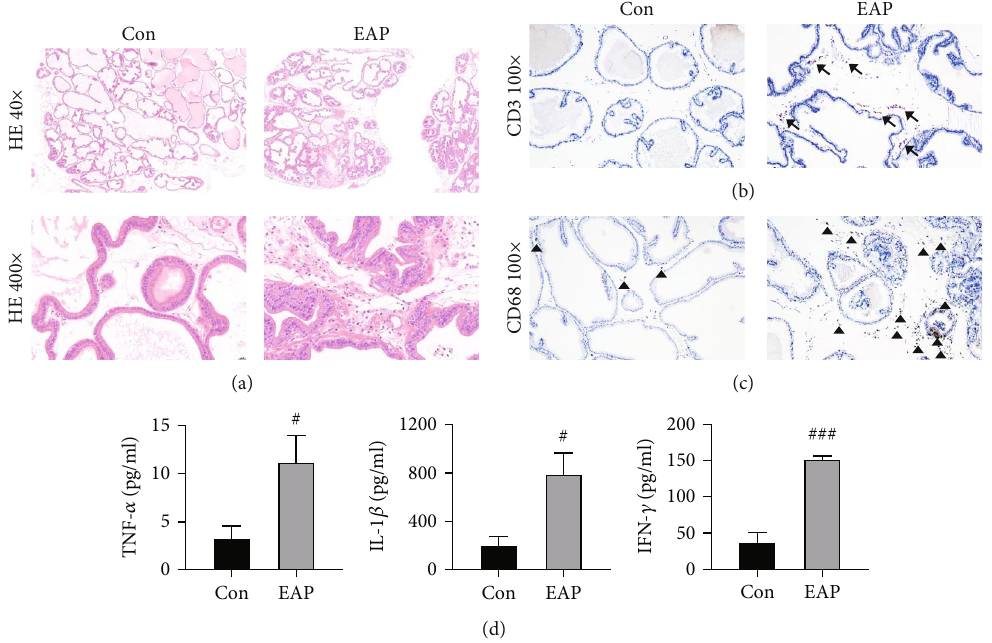
Figure 2: Development of EAP model through immunization of prostate extract. (a) Representative HE-stained histopathological images of the prostate specimens. (b, c) IHC staining for visualizing CD3-positive T cells indicated by arrows and CD68-positive macrophages indicated by triangles in the prostate specimens. (d) The serum contents of proin fl ammatory cytokines TNF- α , IL-1 β , and IFN- γ in the control and EAP groups were determined by ELISA kits. Data was presented as mean ± SEM . # P < 0 : 05 versus the control group; ### P < 0 : 001 versus the control